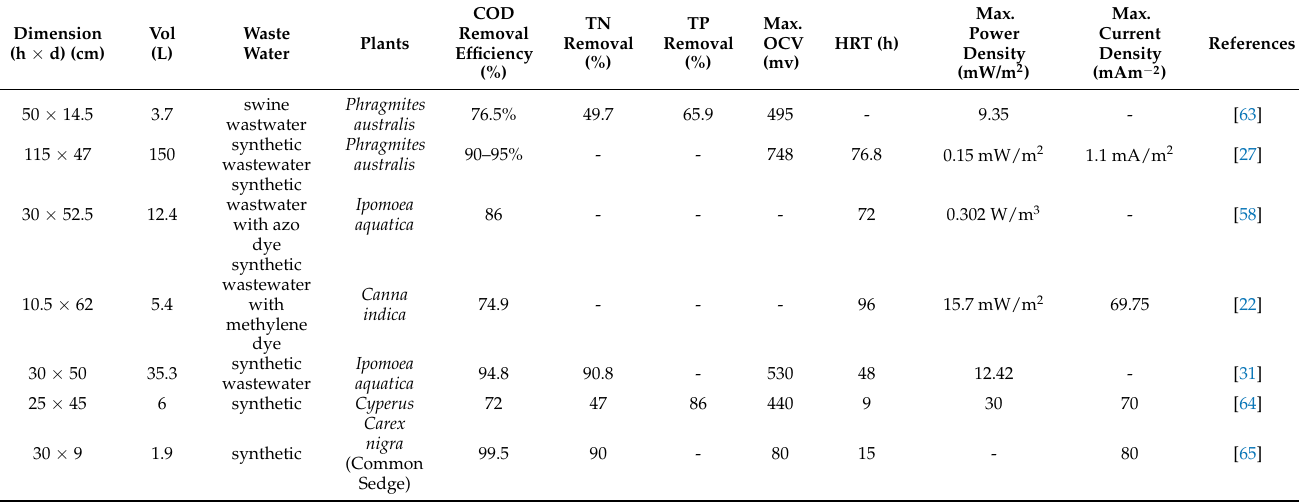
Table 3. Application of CW-MFCs for wastewater treatment and power